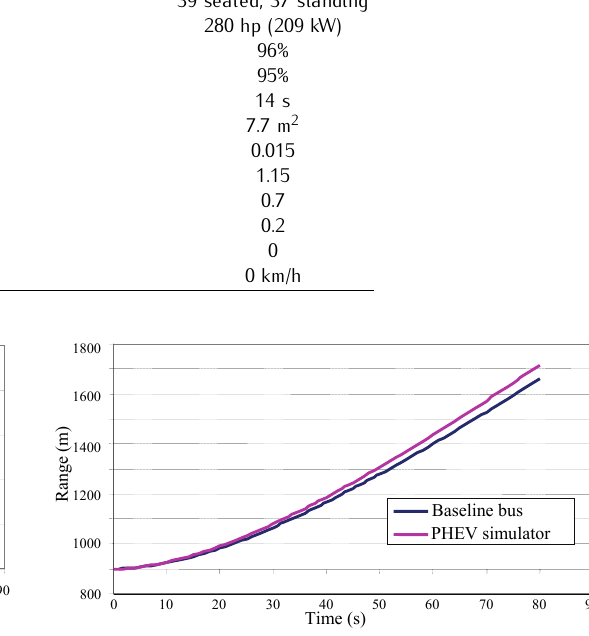
Figure 3. Comparison of the total engine power.